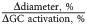
Dynamical model of NO-induced dilation shows a post-stimulus undershoot.All simulations for this figure used a dynamic model with a baseline diameter of 20 μm. A) NO production in the proximal model was increased 100% for 1 second in these simulations with a baseline NO production set at EC50 (the concentration of NO that produces half maximal activation of GC) in the smooth muscle. B) Arteriole dilation increases the supply of RBCs in the variable RBC model, where the RBC core changes diameter with vessel diameter. The arteriole dilates (red) in response to increased NO in the smooth muscle (black); however, after NO production returns to baseline the arteriole is still dilated. The dilated arteriole can accommodate more RBCs which depletes NO below baseline. The depletion of NO concentrations below baseline is reflected in a corresponding post-stimulus constriction. Five different sensitivities to GC (m = 1,2,3,4,5 Δdiameter,%ΔGCactivation,%) are shown. C) Dilation in the constant RBC core case does not increase RBC supply or the degradation rate of NO. Note that fixed core model is not realistic. When vasodilation does not increase NO consumption, NO concentrations do not fall below baseline and no post-stimulus constriction occurs. D) Dilations for m = 5 Δdiameter,%ΔGCactivation,% rescaled to the same height showing the relative size of the post-stimulus constriction in the variable RBC core case while none is present if the RBC core is held constant during vasodilation.